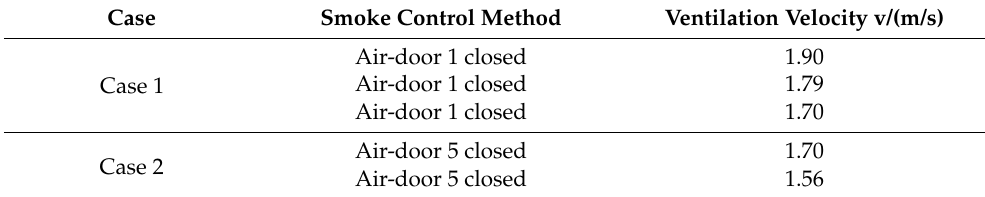
Table 2. Ventilation network with a diagonal branch scheme setting.